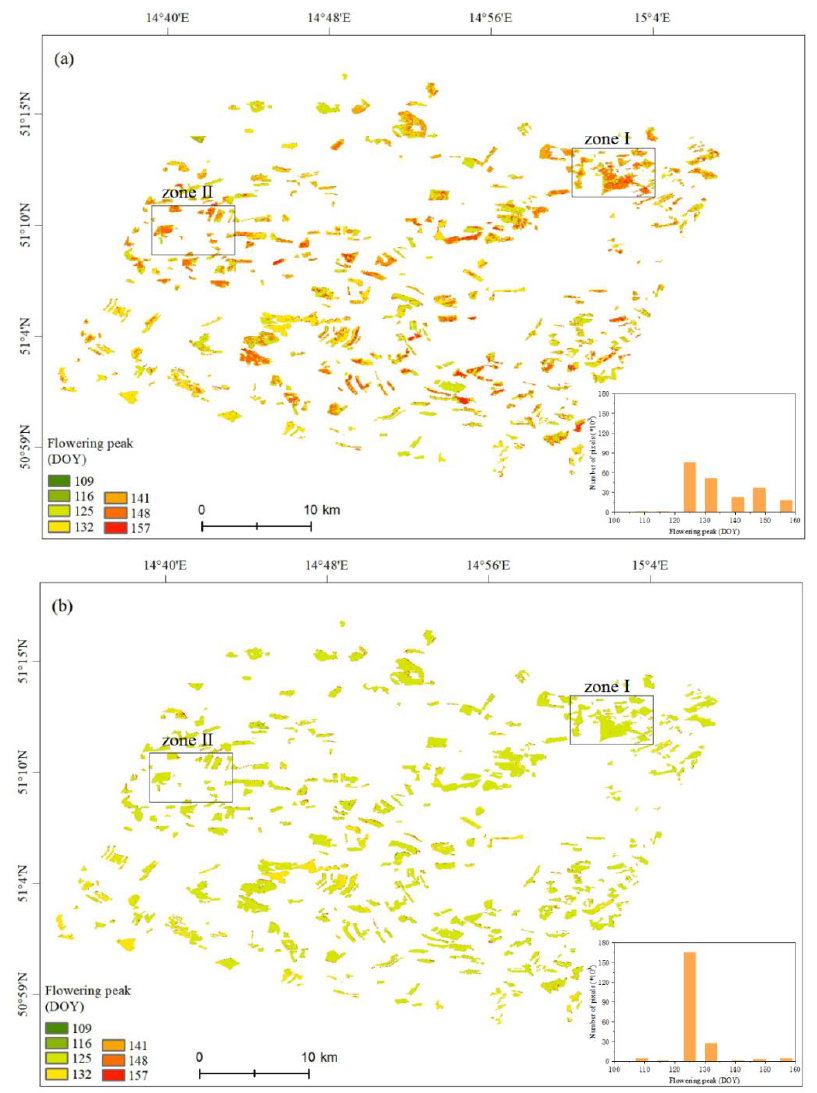
Figure A1. Flowering peak (Day of Year, DOY) as obtained by ( a ) NDYI and ( b ) NRFIr from Landsat-8 images in 2018 in the study area. Histogram depicts the numbers of pixels of rapeseed flowering peak.